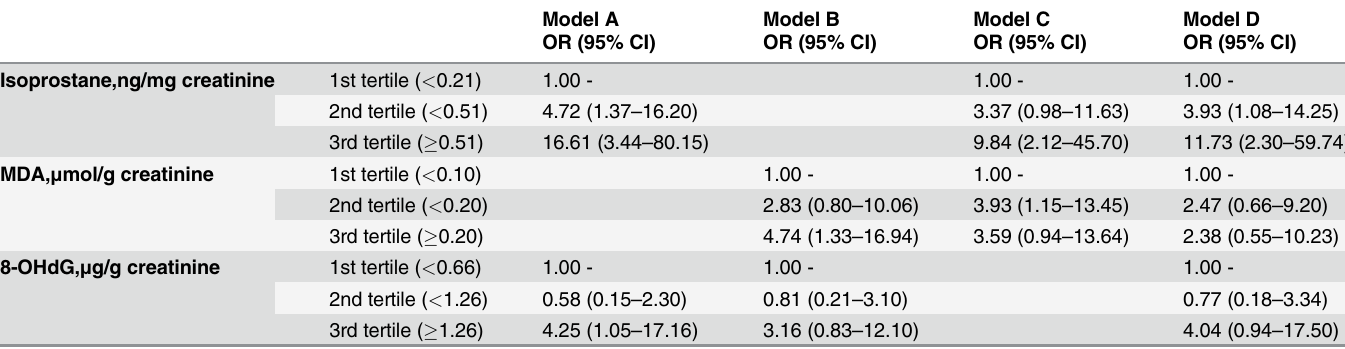
Table 3. Independent relationship among oxidative damage markers to carotid intima media